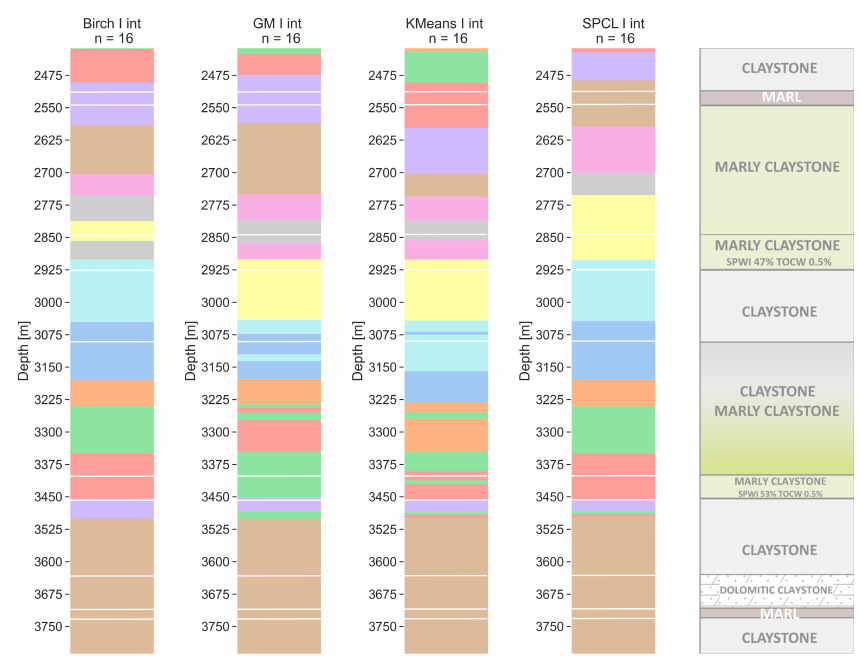
Figure 13. Sonic tool resolution clustering models for a number of clusters equal to 16 with lithology from well core (with lines). Clustering methods: BIRCH—balanced iterative reducing and clustering using hierarchies, GM—Gaussian mixture model, k-means, and SPCL—spectral